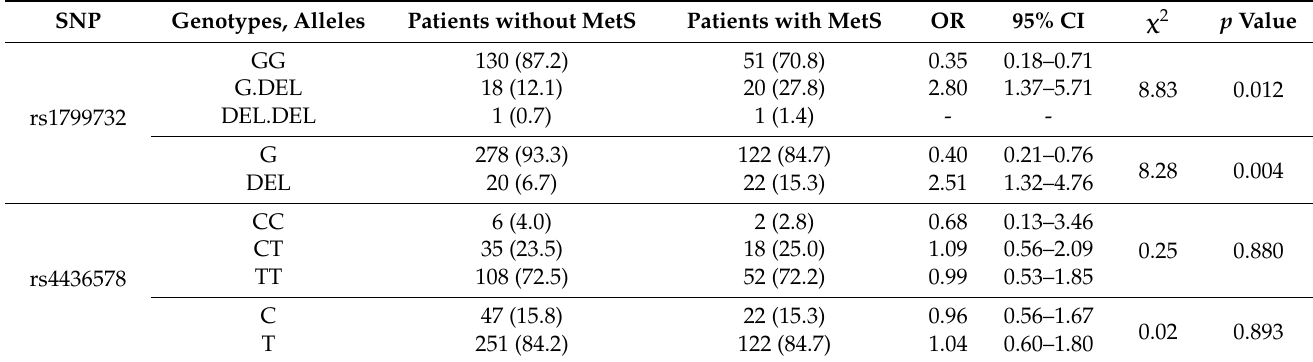
Table 4. Distribution of alleles and genotypes of DRD2 polymorphisms in groups of female patients without and with